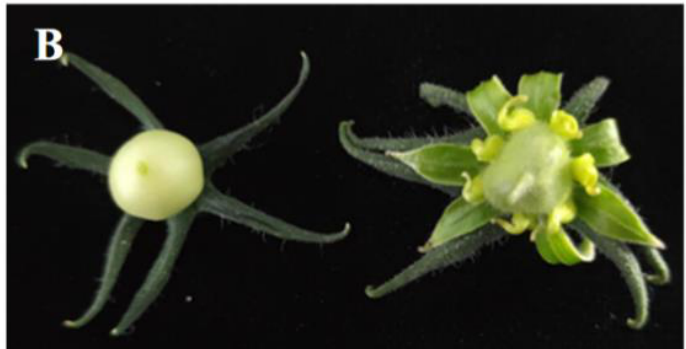
Figure 8. Phenotypes of transgenic plants overexpressing the LsOVATE1 gene compared to wild-type (WT) tomato. ( A ) shows the flowers of the representative transgenic line (right) and that of the WT (left); ( B ) shows the young fruits of the representative transgenic line (right) and that of the WT (left).